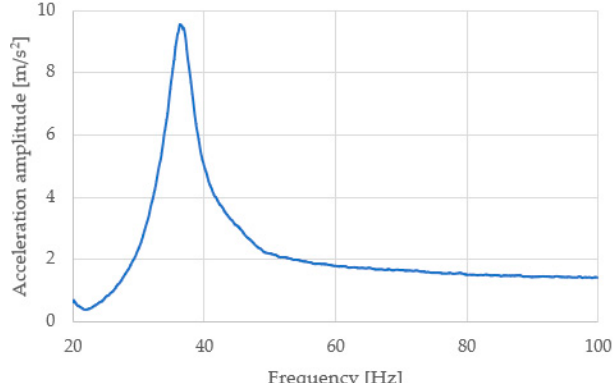
Figure 4. Acceleration amplitude spectrum (blue line) for the sample set h = 10 mm and 8 pcs. The resonant frequency of the tested system is equal to 36.4 Hz.